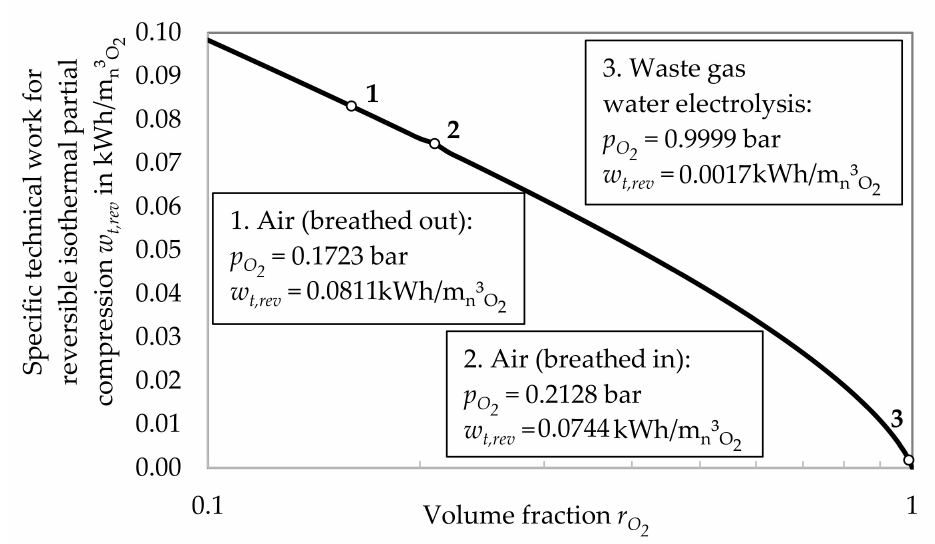
Figure 2. Energy demand for oxygen generation with rev. isothermal partial compression over r O